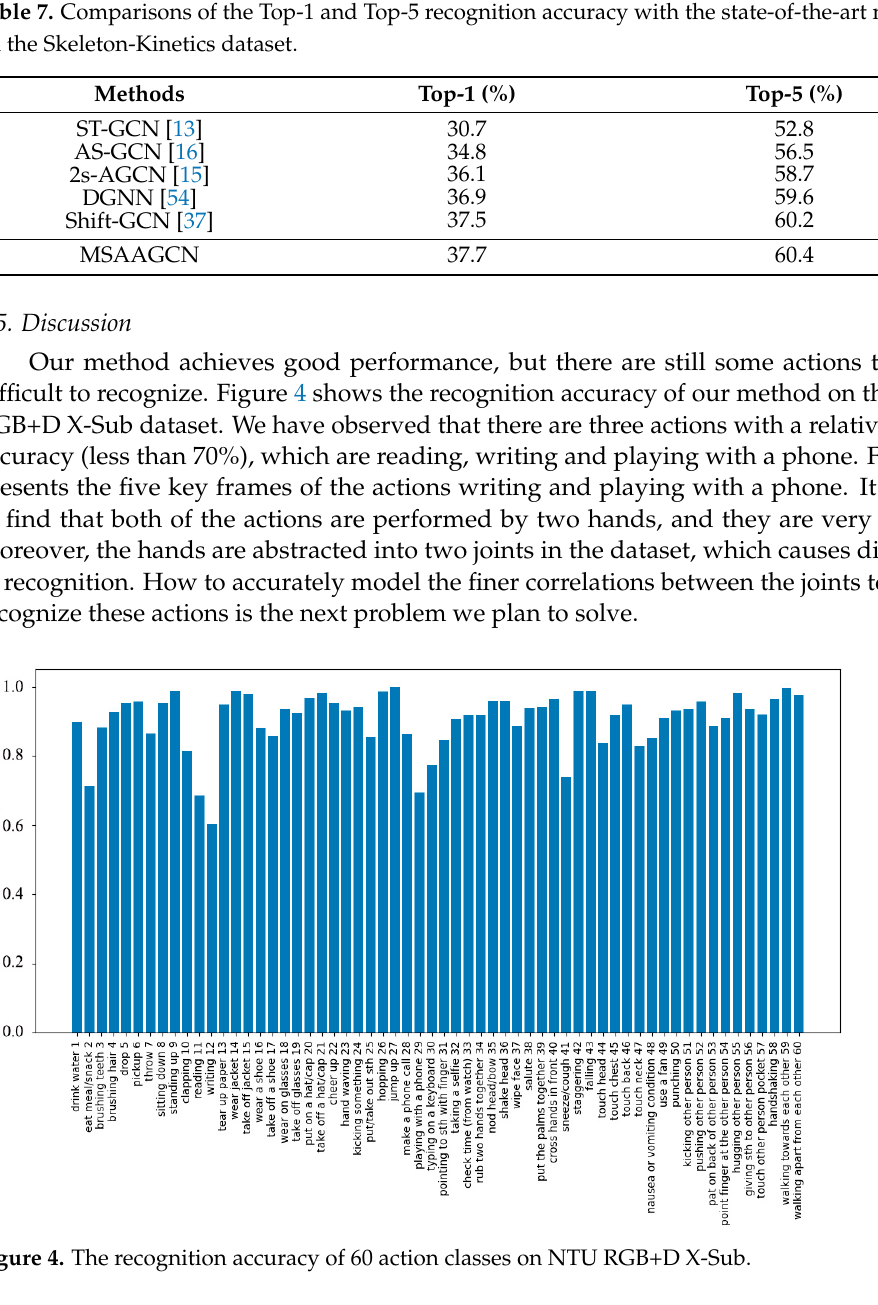
Figure 5. Visualization of the two actions of writing and playing with a phone. For each action, we selected five key frames to represent. 5. Conclusion s In this work, we proposed a multi-stream model consisting of multi-scale aggregate GCN, multi-scale adaptive TCN and STCAtt modules for skeleton-based action recogni- tion. We fed the skeleton sequence into the spatio-temporal module and constructed multi-order adjacency matrices in the spatial module to obtain the remote dependence and multi-scale semantic information of the joints. In the temporal module, we added a temporal convolution kernel with three ranges of long, medium and short to provide a more flexible receptive field for the temporal feature map. Additionally, we introduced an attention mechanism to focus on distinct key joints and frames and channel infor- mation to avoid the interference of redundant information. Moreover, we improved the utilization of features through residual connections between blocks and modules. Finally, with extensive ablation experiments and comparison experiments on three large-scale da- tasets, the results show that our proposed model achieves good performance.